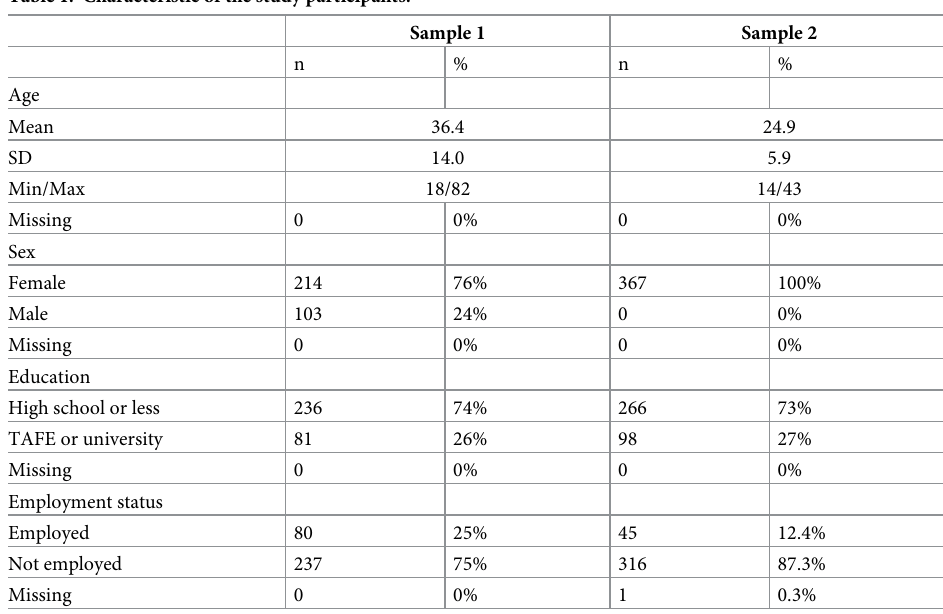
Table 1. Characteristic of the study participants.